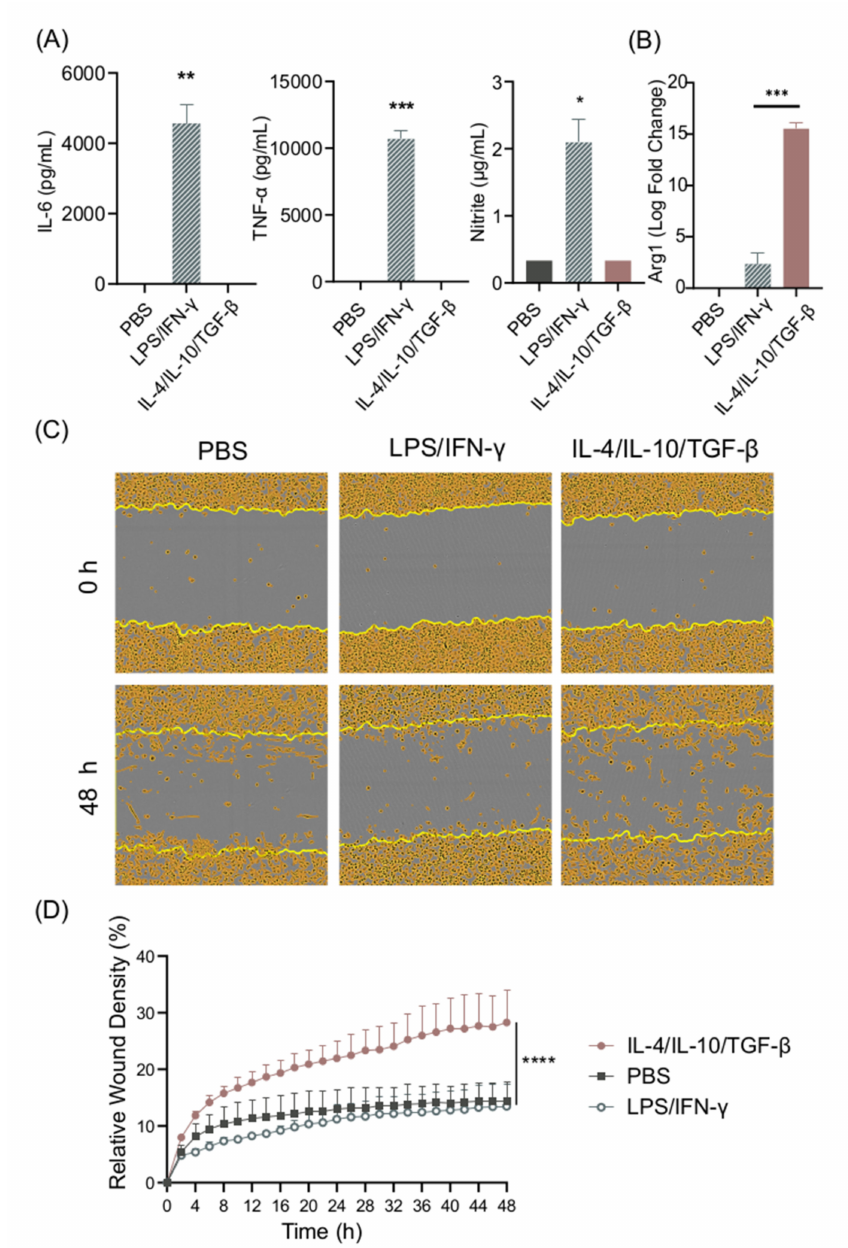
Figure 1. LPS/IFN- γ induce M1 polarization, while IL-4/IL-10/TGF- β induce M2 polarization. ( A ) IL-6, TNF- α , and nitrite secretion from BMDM supernatants after 24 h stimulation with LPS/IFN- γ or IL-4/IL-10/TGF- β , and ( B ) Arg1 gene expression in murine BMDMs stimulated with LPS/IFN- γ or IL-4/IL-10/TGF- β . ( C , D ) The cell migration ability of BMDMs stimulated with LPS/IFN- γ and IL-4/IL-10/TGF- β was measured using a scratch assay. ( C ) Representative images of scratch assay, and ( D ) the relative wound density of BMDMs stimulated with LPS/IFN- γ and IL-4/IL-10/TGF- β . Data represent n = 3 (mean + SD). Statistical analysis was performed using ( A ) a one-sample t -test, ( B ) t -test, and ( D ) a one-way ANOVA. * p ≤ 0.05, ** p ≤ 0.01, *** p ≤ 0.001, **** p < 0.0001. 3.2. dsHMGB1 Upregulates Expression of Cytokines, but Does Not Cause BMDMs to Secrete NO BMDM cultures were stimulated with different concentrations of dsHMGB1 or frHMGB1 for 24h. dsHMGB1 stimulation induced significant release of IL-6, TNF- α , and IL-10 in a dose-dependent manner. LPS/IFN- γ stimulation induced significant release of IL-6 and TNF- α , but no IL-10 production. (Figure 2A–C). In contrast, dsHMGB1